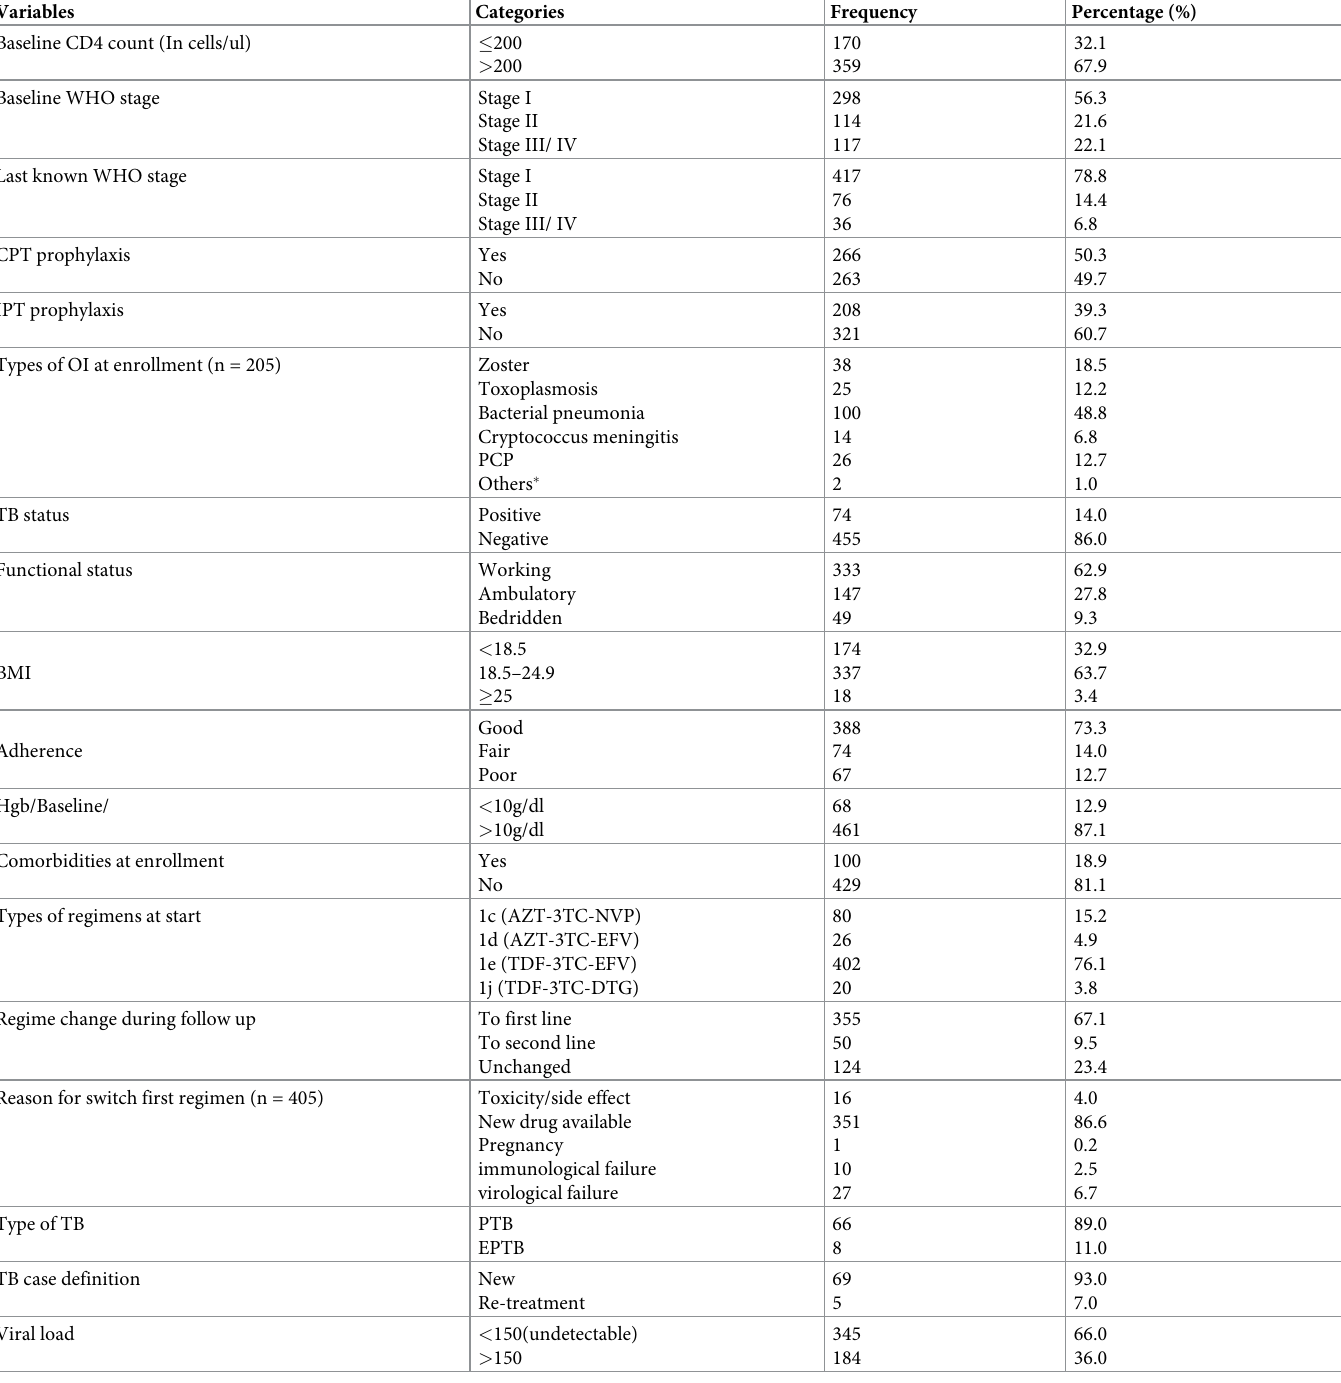
Table 2. Clinical and treatment related characteristics of adult HIV patients on ART in St. peter specialized hospital and Zewditu memorial Hospital between Janu- ary 1, 2016 and August 25,